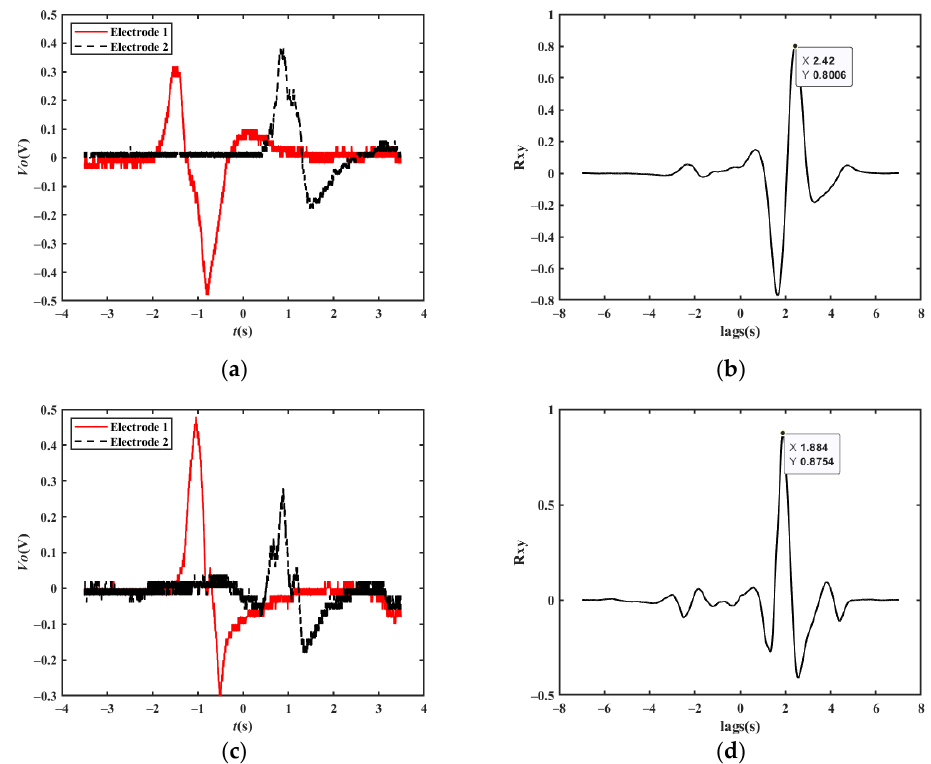
Figure 23. Experimental results in night environment: ( a ) original waveforms at a velocity of 23 km/h; ( b ) cross-correlation results at a velocity of 23 km/h; ( c ) original waveforms at a velocity of 30 km/h with changing lanes; ( d ) cross-correlation results at a velocity of 30 km/h with changing lanes.